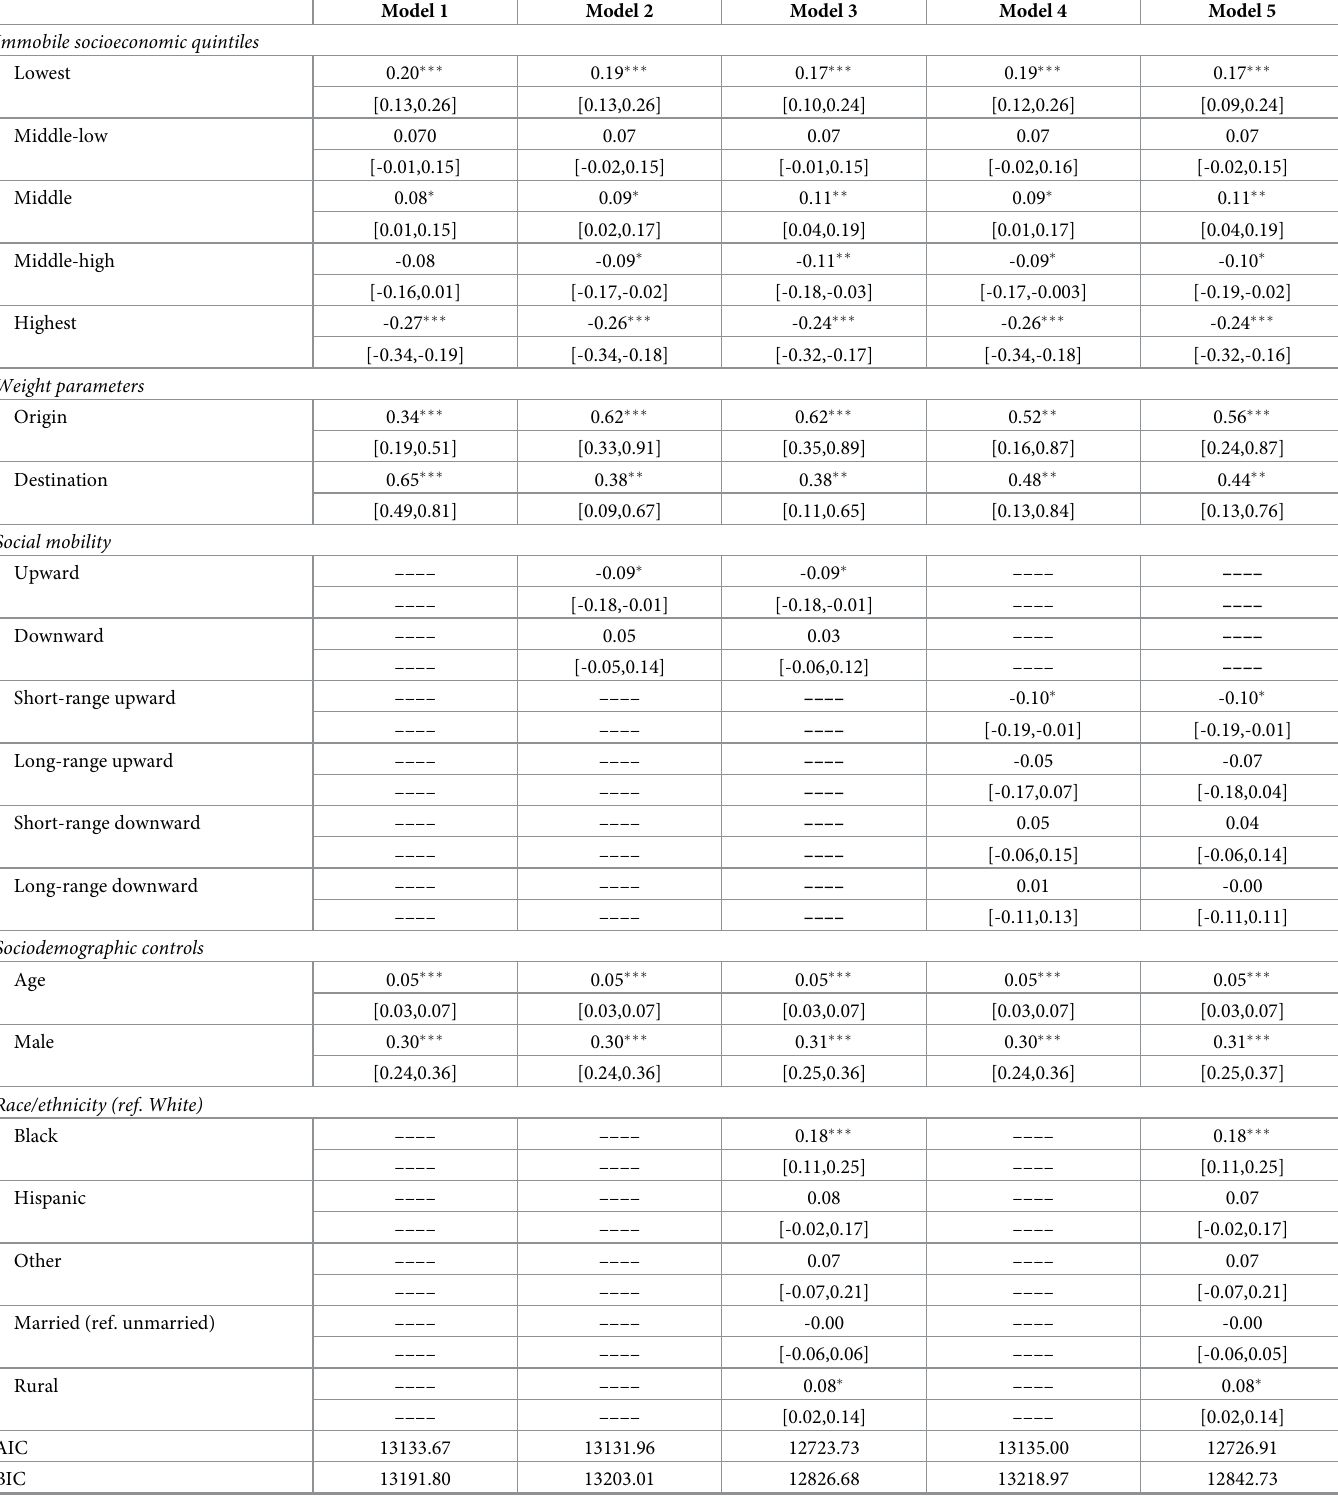
Table 3. Point estimates from DRM on AL